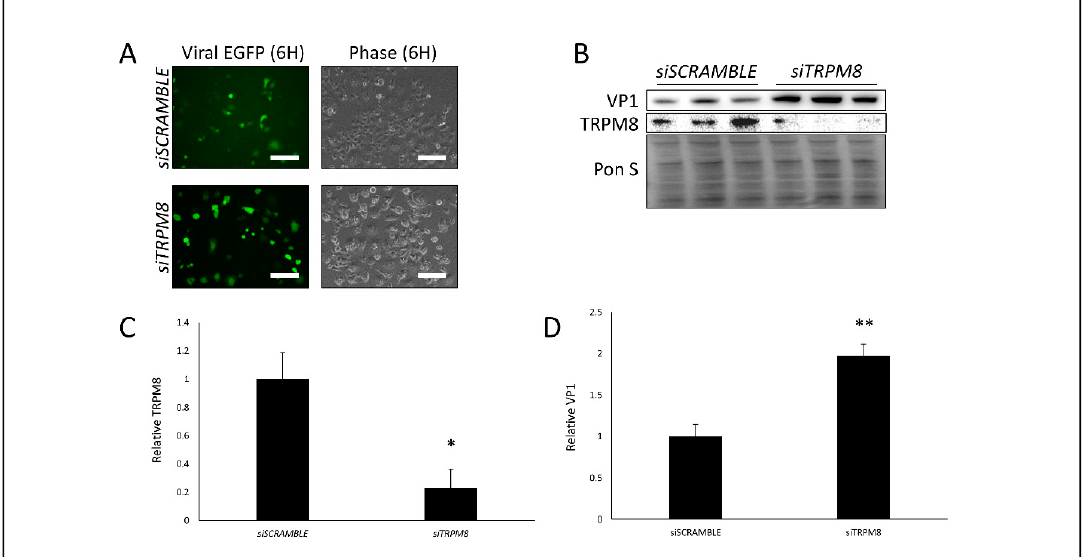
Figure 4. Silencing TRPM8 bolsters CVB infection- HeLa cells were transfected with siRNA targeting TRPM8 (siTRPM8) or scrambled RNA (siSCRAMBLE) for 72 h and subsequently infected with EGFP-CVB at MOI 1 for 6 h. ( A ) Fluorescence microscopy comparing viral EGFP expression between cells transfected with either siSCRAMBLE or siTRPM8. Phase contrast images of same fluorescence image fields are shown to the right. Scale bars represent 150 µ m. ( B ) Western blot on cell lysates from A detecting TRPM8 and VP1 viral capsid protein. Ponceau S is shown below. ( C ) Densitometric quantification of TRPM8 western blot in B. (* p < 0.05; Student’s t-test, n = 3). ( D ) Densitometric quantification of VP1 western blot in B. (** p < 0.01; Student’s t-test, n = 3).